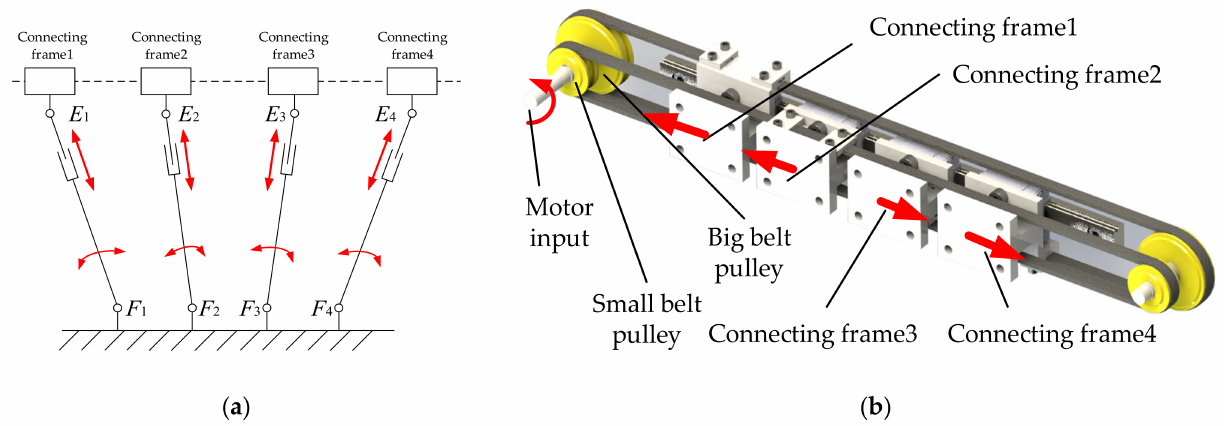
Figure 9. Introduction of the adduction/adduction module. ( a ) The working principle; ( b ) the drive